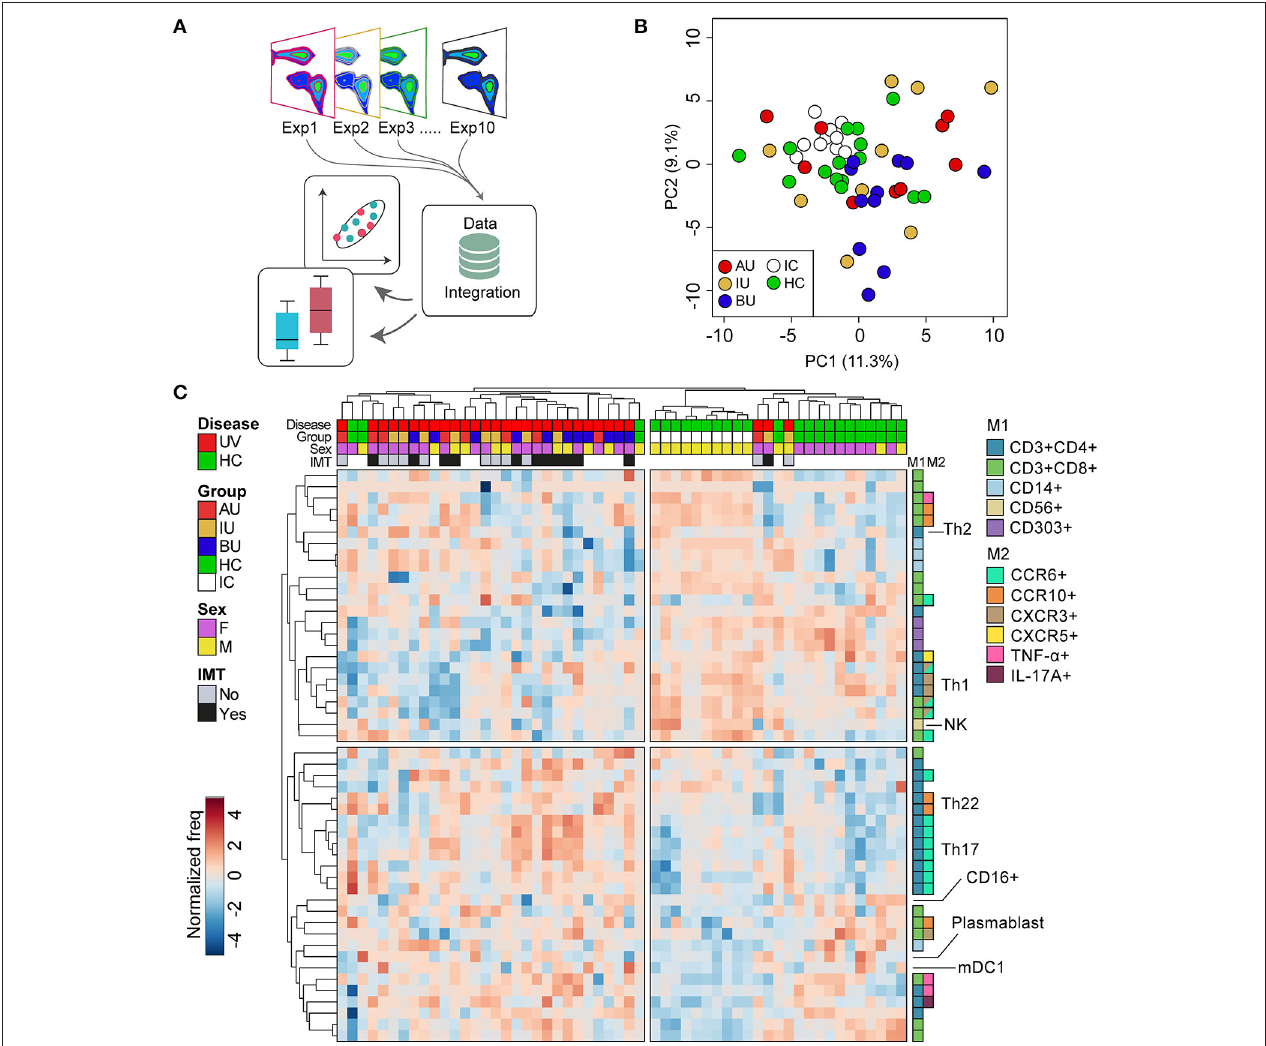
FIGURE 1 | The overall blood leukocyte composition is changed in non-infectious uveitis (A) . We performed high-dimensional immune profiling of blood of non-infectious uveitis and control samples by multi-color flow cytometry in 10 independent experiments that were integrated for meta-analyses. (B) Principal component analysis (projection onto first two principal components) of the combined flow cytometry data of the 45 samples of this study, including the “internal control” (i.e., an aliquot from a single healthy donor isolated and frozen at the same day) that was taken along for each experiment. The close clustering of the internal control samples across all experiments as shown in the projection of the first two components indicates low inter-experiment variability. (C) Heatmap of unsupervised hierarchical clustering of the 50 manually gated cell subsets which largest variability between the groups (based on the ANOVA). Heatmap colors represent the changes in proportion from relatively lower proportion (in blue) to higher proportion (in red). Dendrograms indicating the clustering relationships between disease groups and leukocyte populations are shown to the left and above the heatmap. The sample meta-data are indicated above and the leukocyte subsets contributing to these clusters are indicated on the right. M1: first color marker to define leukocyte population. M2: additional color marker to define chemokine receptor and/or cytokine production. Populations with the same M1 and M2 colors differ in additional (not highlighted) protein markers (e.g., CD161) or represent the same population in a different gated population (% of CD4 + CD45RO + vs. % of CD3). AU, HLA-B27 associated anterior uveitis; BU, Birdshot Uveitis; F, female; HC, healthy control; IC, internal control; IMT, requirement for systemic (non-corticosteroid) immunosuppressive therapy during follow-up; IU, idiopathic intermediate uveitis; M, male;